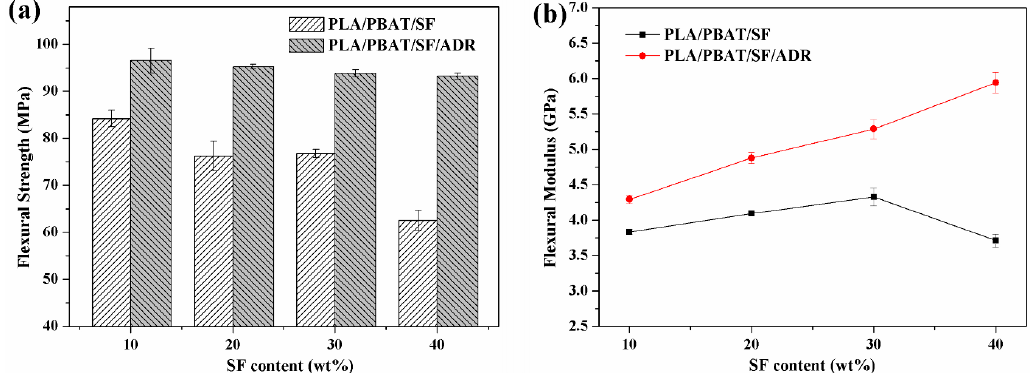
Figure 10. Flexural strength ( a ) and flexural modulus ( b ) of PLA / PBAT / SF and PLA / PBAT / SF / ADR composites with di ff erent SF